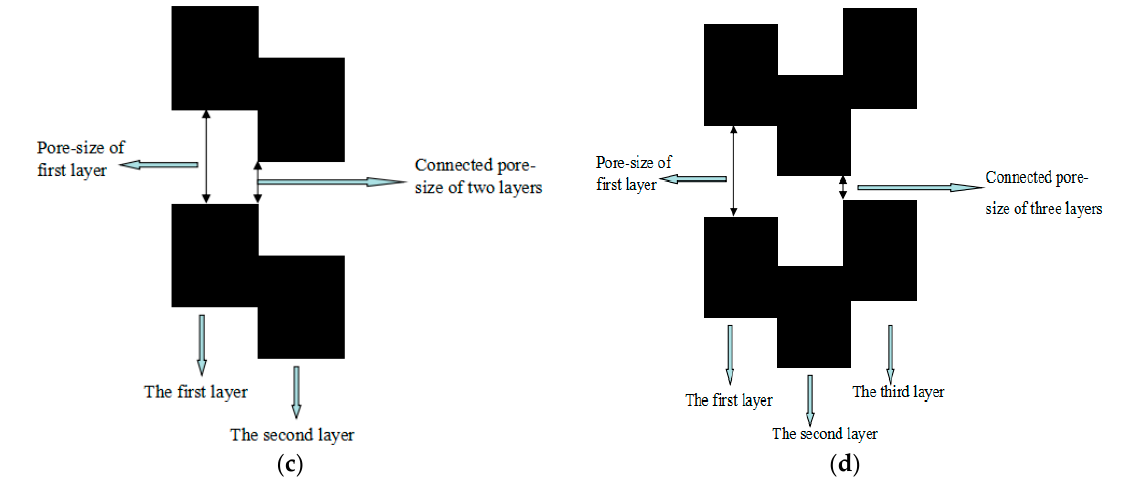
Figure 3. Diagram of the sample scale effect for the equivalent connected pore size. ( a ) ichnography for two layers; ( b ) ichnography for three layers; ( c ) cross section for two layers and ( d ) cross section for three layers.